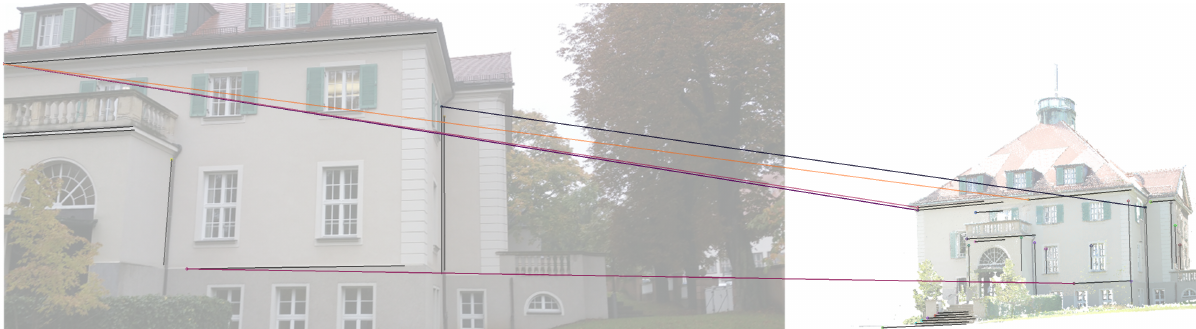
Figure 11: Schematic representation of the line matching result for the principalship with a smartphone (left) and a synthetic image (right). Matched lines are shown by coloured connections of their starting